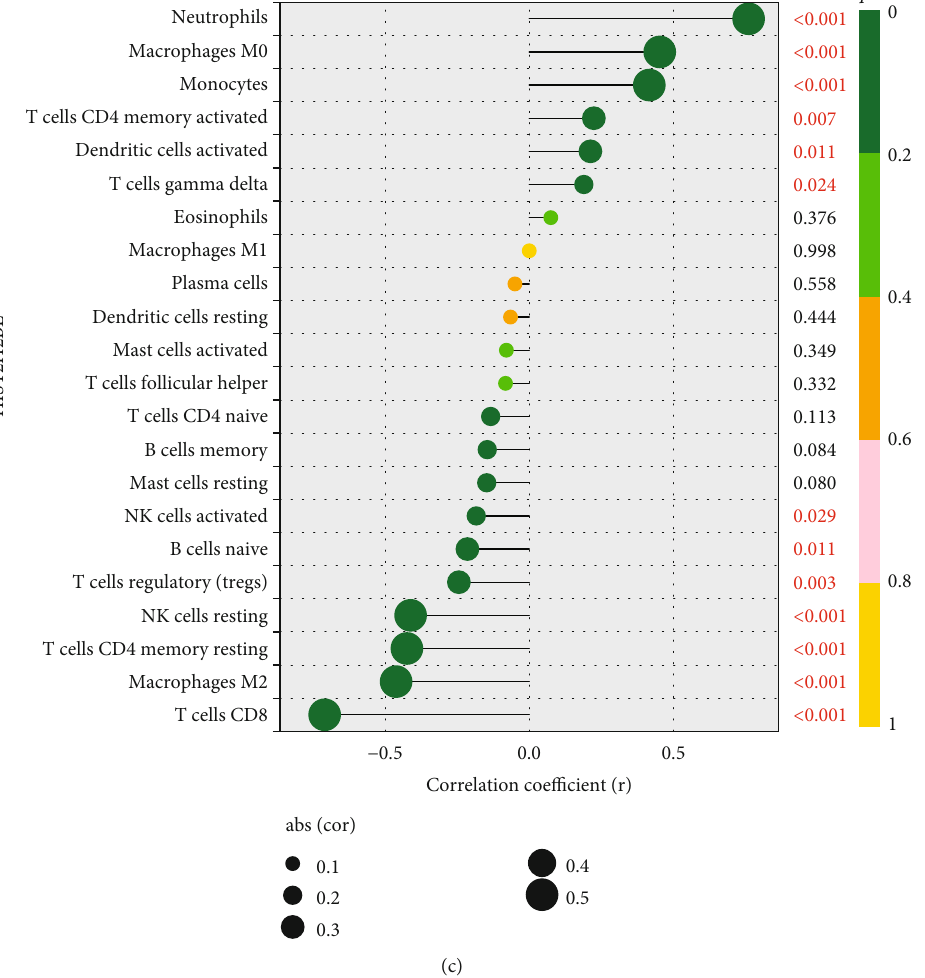
Figure 7: Correlation between ALPL (a), EDEM2 (b), HIST2H2BE (c), and in fi ltrating immune cells in Kawasaki